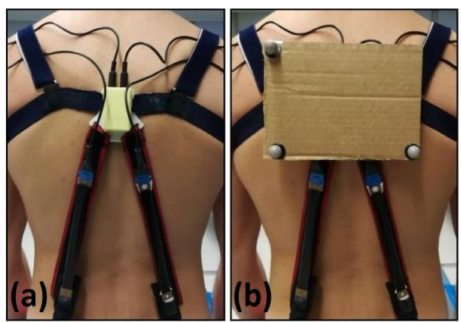
Figure 3. The electronics box ( a ) was equipped with a support for three optical markers ( b ), in order to enable optical tracking of movements of the box via